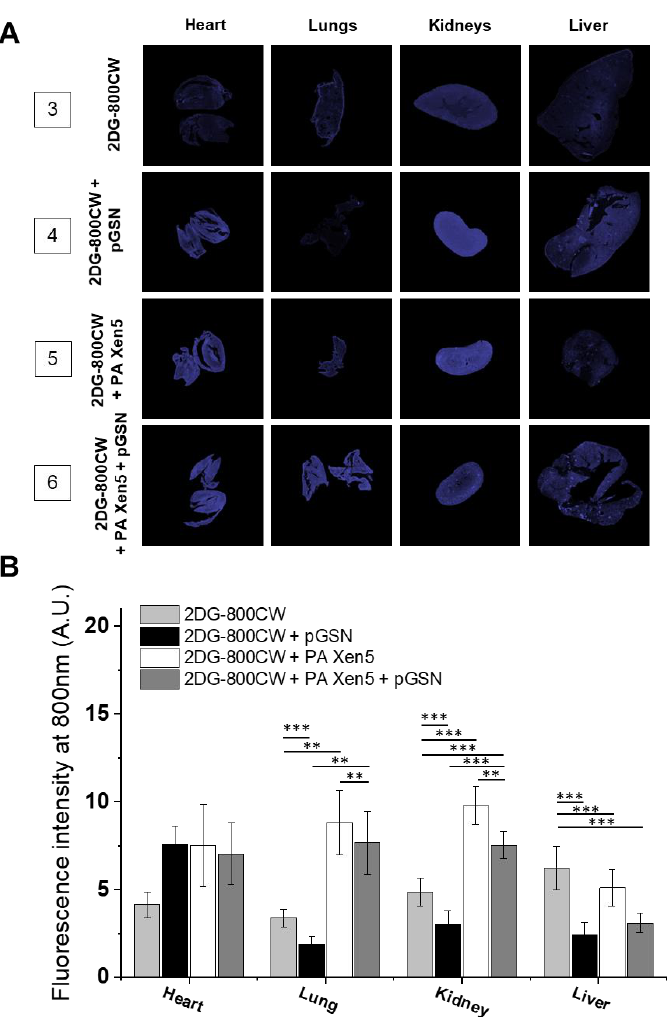
Figure 3. Estimation of inflammation burden in Cby.Cg-Foxn1nu / cmdb mice organs based on measurement of 2DG-800CW-targeted fluorescence intensity. At the start of the experiment mice were injected intravenously with sterile saline (groups 3 and 4) or PA Xen5 inoculum (groups 5 and 6).